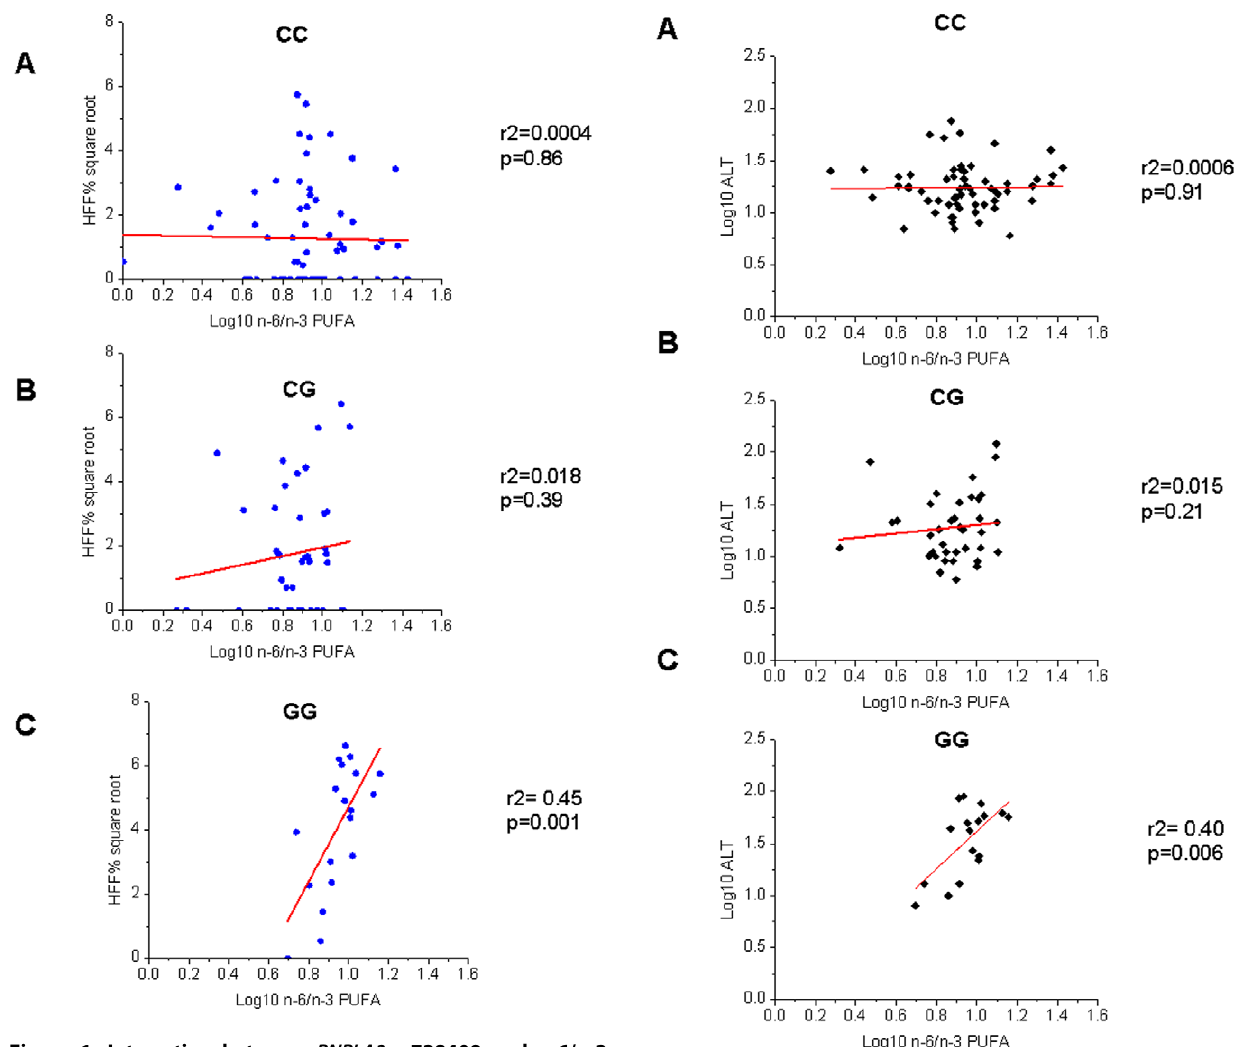
Figure 1. Interaction between PNPLA3 rs738409 and n-6/n-3 PUFA in modulating HFF%. The figure shows a different degree of regression between HFF% (square root) and n-6/n-3 PUFA (log10) in the three genotypes. In the CC (Panel A) and CG (Panel B) group there was no association between HFF% and n-6/n-3 PUFA (r2=0.0004, p=0.86 and r2=0.018, p=0.39, respectively). Only in the GG group (Panel C) there was a strong association between HFF% and n-6/n-3 PUFA (r2= 0.45, p=0.001).